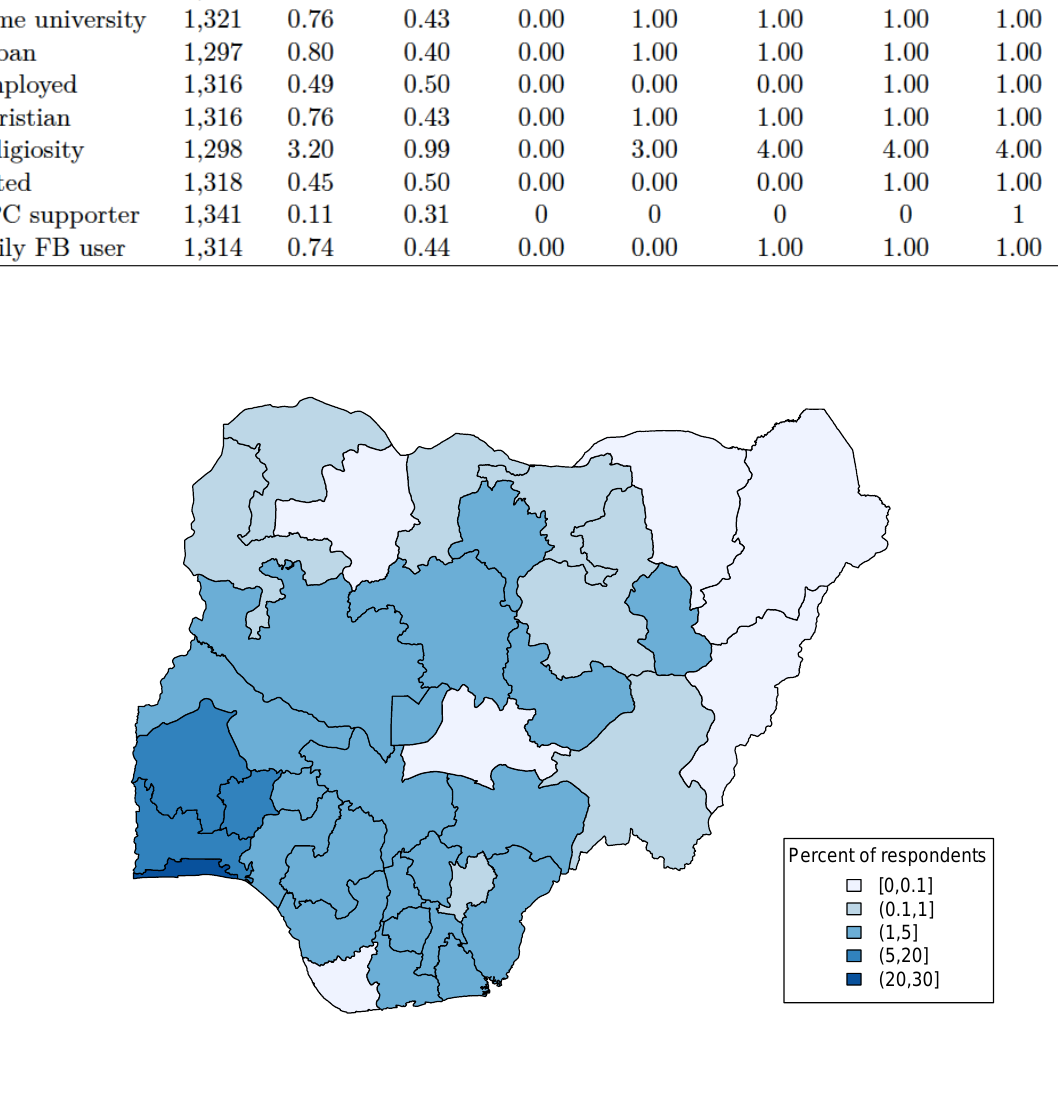
Figure A1. Percent of respondents from each state in